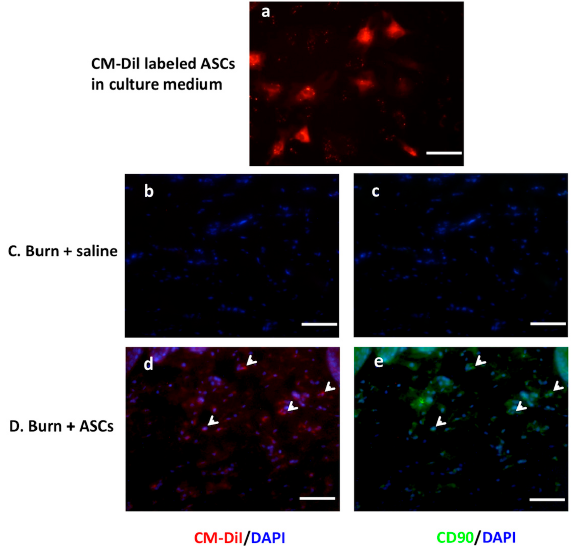
Figure 2. Engraftment of cultured ASCs into the post-burn dermis. ( a ). CellTracker CM-Dil-labeled cells (red spots) were detected among the cultured rat ASCs in culture medium at passage 4 before harvesting for treatment; ( b , c ) no double staining of CM-Dil/DAPI (blue) and CD90/DAPI detected in the same field within dermis 4 weeks after subcutaneous saline injection in Group C; ( d , e ) double staining of CM-Dil (red)/DAPI (blue) and CD90 (green)/DAPI in the same field (arrowheads) indicate the viable ASCs within the dermis 4 weeks after cultured ASC transplantation in Group D (fluorescence microscopic images; magnification, × 200).